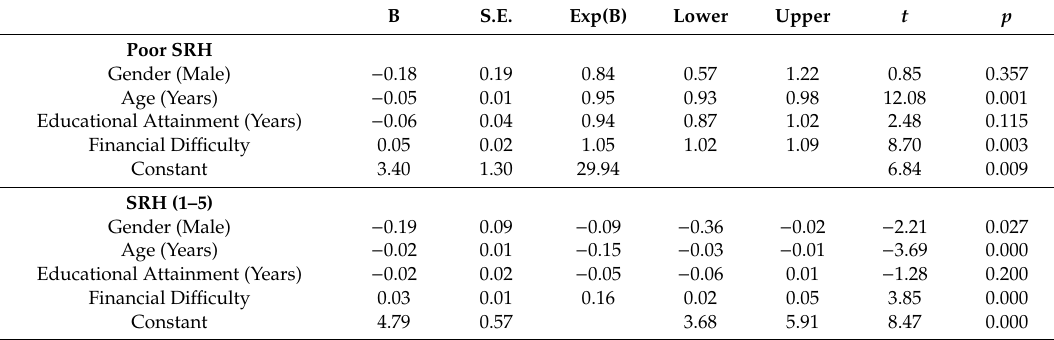
Table A1. Associations between age and self-rated health (SRH) in the pooled sample. B S.E. Exp(B) Lower Upper t p Poor SRH Gender (Male) − 0.18 0.19 0.84 0.85 − 0.05 0.01